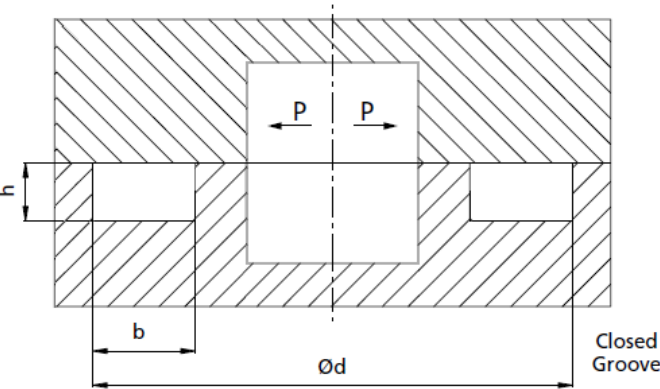
Figure 6. A not-scale representation of the gasket closed groove: h is the groove depth, b is the groove width, and d is the groove